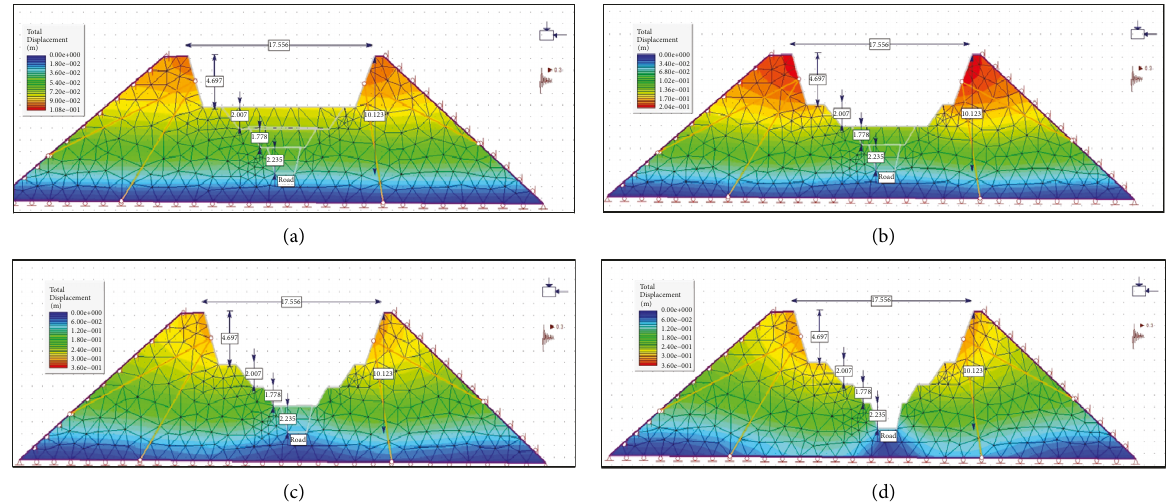
Figure 8: Total displacements simulated (a) at stage 1, (b) stage 2, (c) stage 3, and (d) stage 4 of road